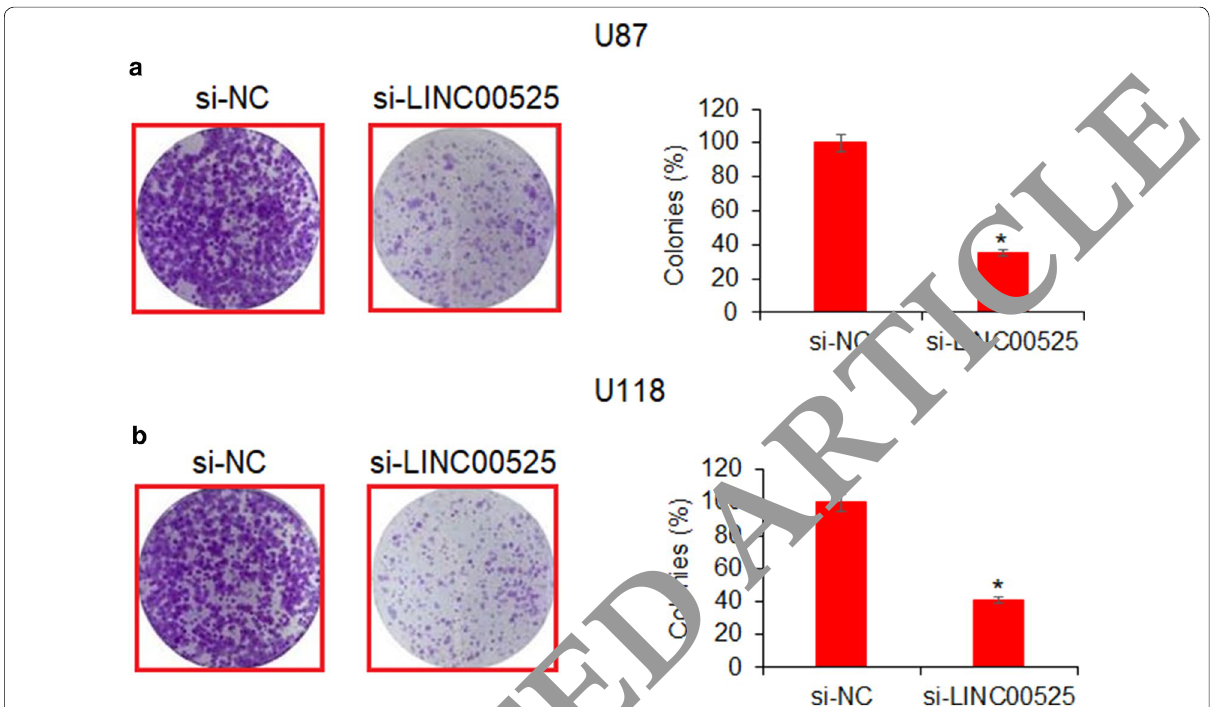
Fig. 2 The transcriptional knockdown of lncRNA-LINC00525 reduced the colony formation by glioma cells, markedly. a Relative colony formation by U87 cancer cells transfected with si-NC or si-LINC00525, b relative colony formation by U118 cancer cells transfected with si-NC or si-LINC00525. The experiments were performed in triplicate and expressed as mean SD (*P < ±